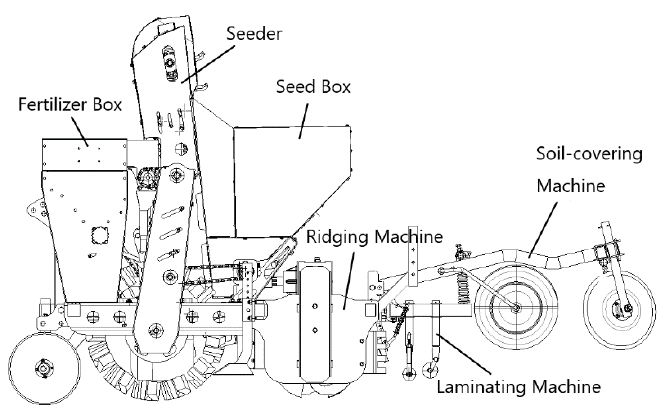
Figure 1. The structure scheme of potato planter.